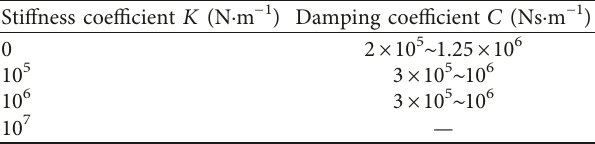
Figure 2: Effects of C and K on control variables and the range of optimum parameters. Table 2: Range of optimum damping coefficient C under earth- quake